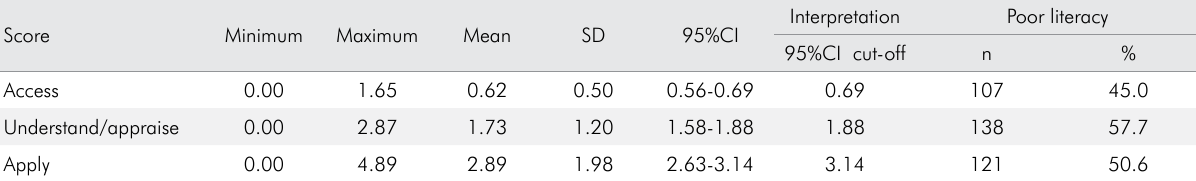
Table 3. Overall scores of the Oral Health Literacy among people with Diabetes questionnaire for the 2nd order three-dimensional model and dimension (access, appraise / understand, and apply) scores in the 1st order three-dimensional model, with minimum and maximum values, means, standard deviation, 95%CI, and